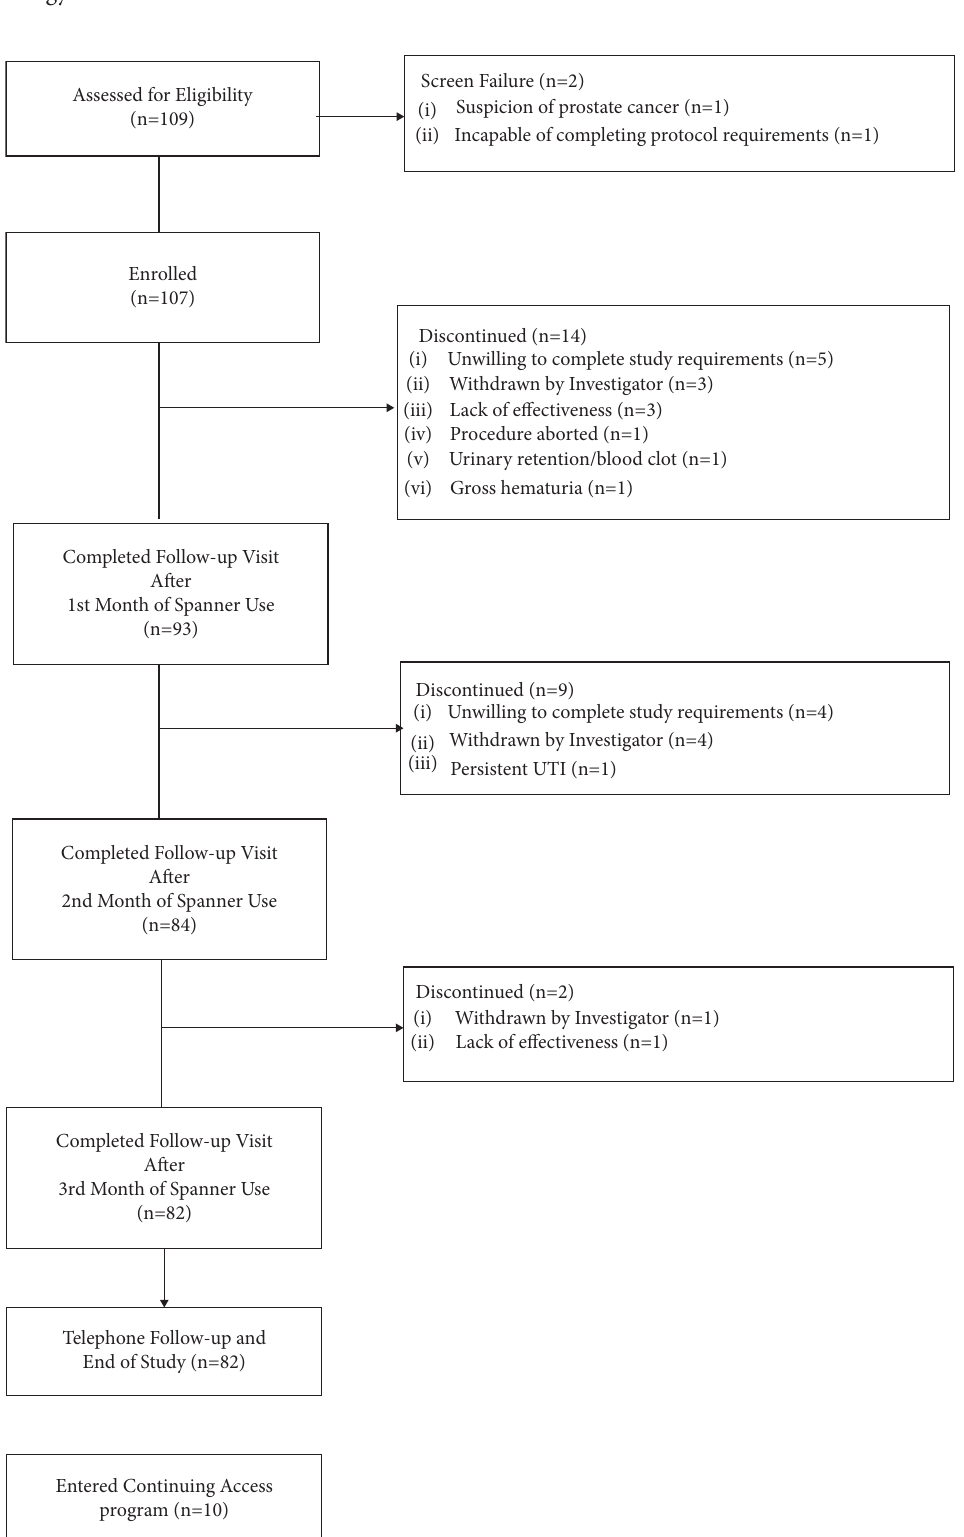
Figure 2: CONSORT diagram of study